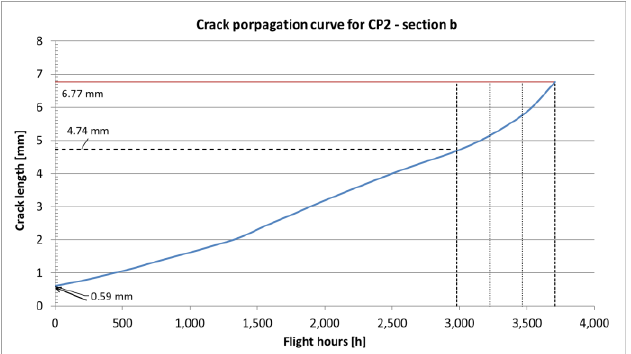
Figure 11. Crack propagation curve and inspection intervals definition for section b of CP2.